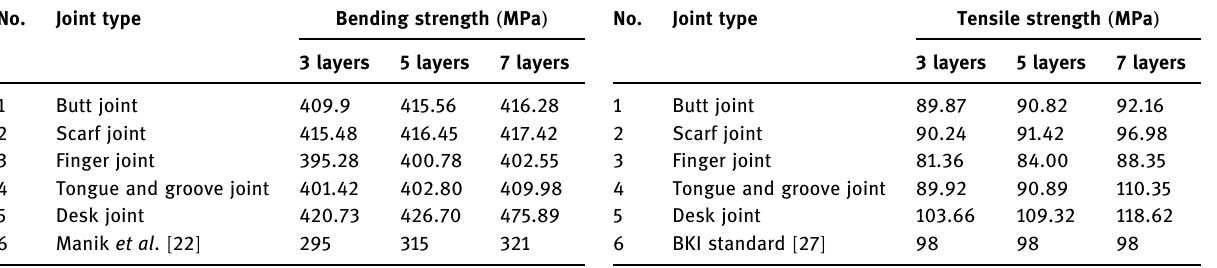
Table 9: Comparison of bending strength under di ff erent joint types No.